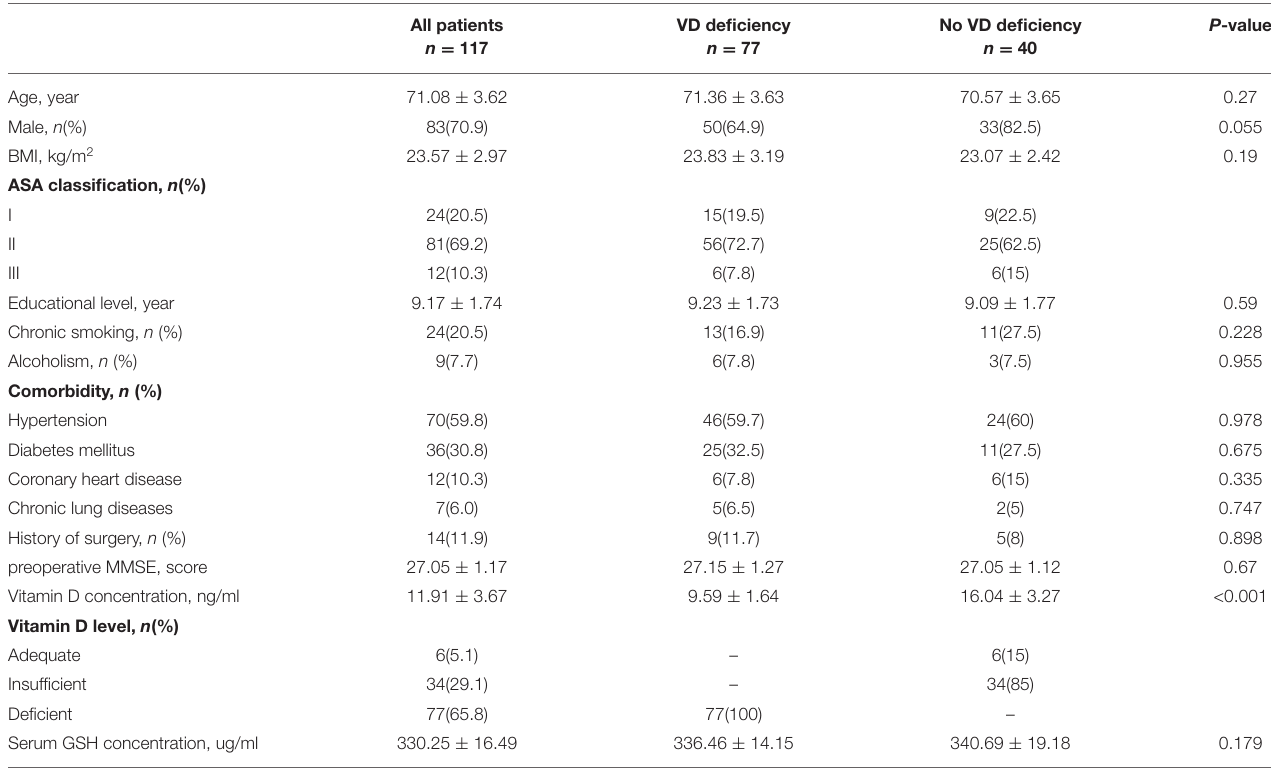
TABLE 1 | Demographic and baseline